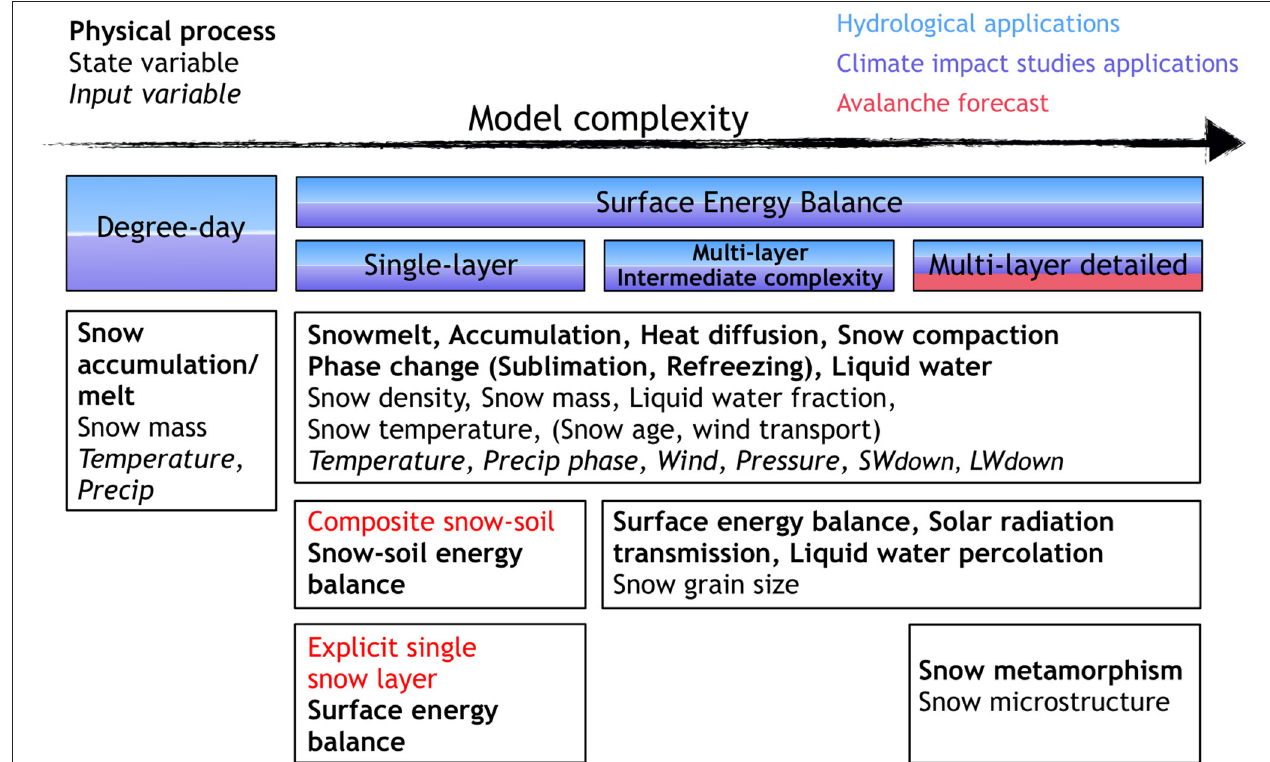
FIGURE 1 | Description of snow physical processes (bold), state variables (regular) and input variables (italic) required per category of snow models complexity for offline